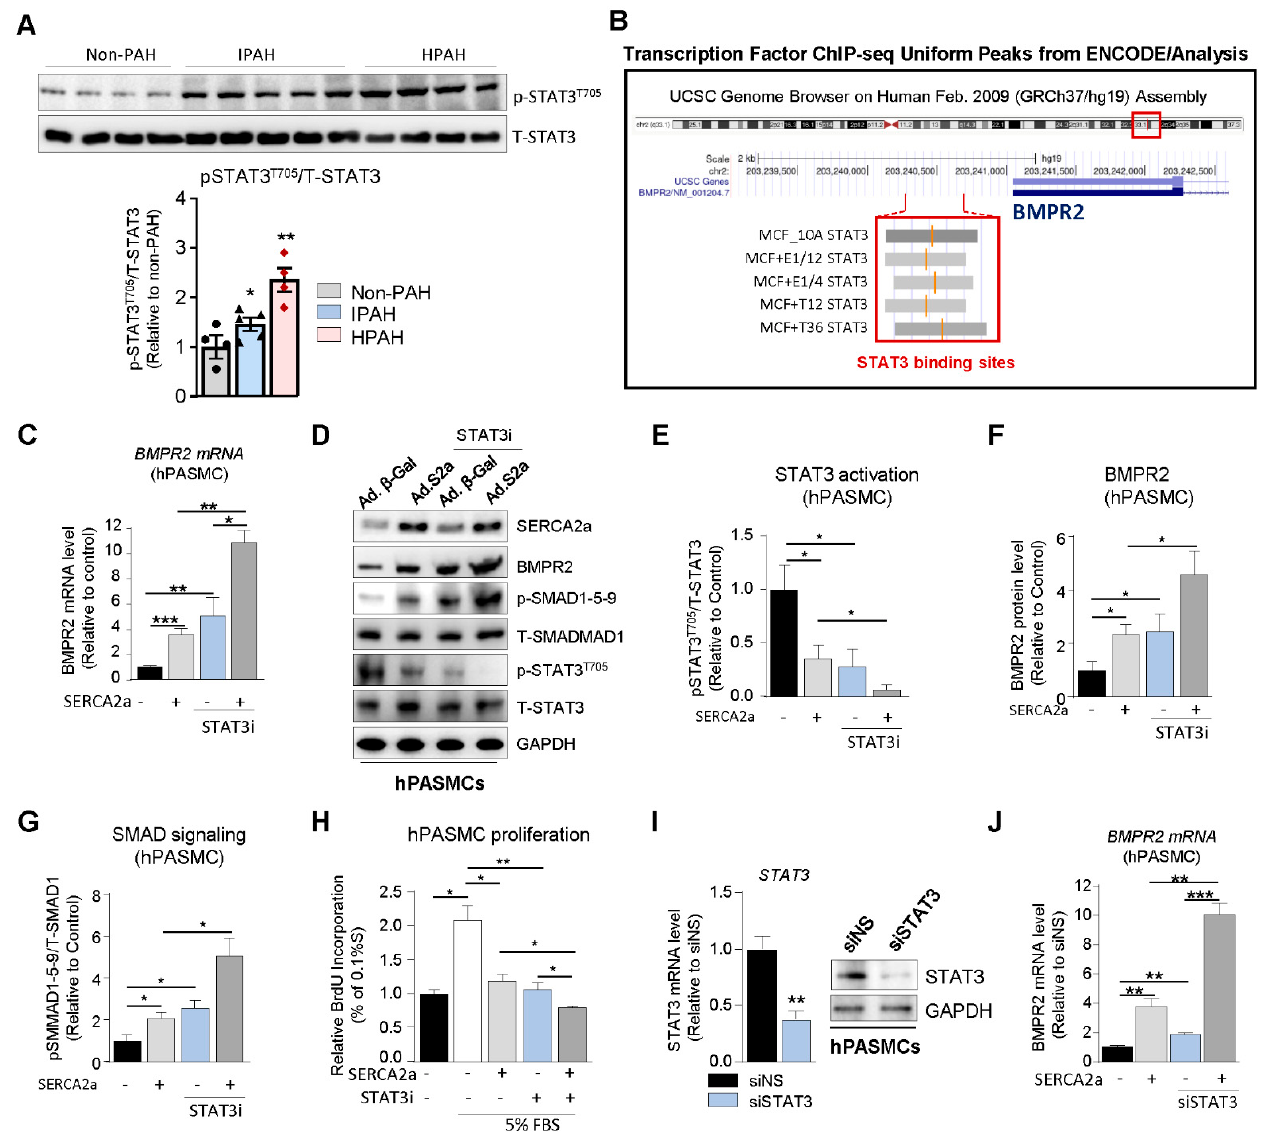
Figure 3. SERCA2a up-regulates BMPR2 expression and downstream SMAD signaling by inhibiting STAT3 activation. ( A ). Upper panel: representative immunoblots of phospho-STAT3 T705 (p-STAT3 T705 ) and Total-STAT3 (T-STAT3) in lung tissue from control non-PAH (n = 4), IPAH (n = 5), and HPAH (n = 4) patients. Total-STAT3 was used as a loading control. Lower panel: the graph represents the quantification of p-STAT3 T705 normalized to T-STAT3. ( B ). BMPR2 promoter region was analyzed for STAT3 binding sites using Transcription Factor ChIP-seq datasets from ENCODE/Analysis (Feb. 2009 data release). ( C ). hPASMCs were transduced with either SERCA2a or a control vector encoding β -Galactosidase (Ad. β Gal) and were treated with potent STAT3 inhibitor HJC0152 (STAT3i) for 48 h (1 μ M). BMPR2 mRNA levels were measured by RT-qPCR in the indicated conditions, n = 3. ( D ). hPASMCs were transduced with a control adenovirus (Ad. β Gal) or SERCA2a (Ad.S2a) and were treated with STAT3i for 48 h (1 μ M). ( E – G ). Bar graph represents the quantification of p-STAT3 T705 ( E ), BMPR2 ( F ), p-SMAD1-5-9 ( G ), and normalized to T-STAT3, GAPDH, and T-SMAD1, respectively, n = 3. ( H ). Proliferation levels were measured through BrdU assay in hPASMCs overexpressing SERCA2a alone for 48 h and/or treated with a potent STAT3 inhibitor (STAT3i, 1 μ M) for 72 h in a media containing 0.1% or 5% FBS, n = 4. ( I ). STAT3 mRNA (left) or protein (right) expression was analyzed by RT-qPCR and Western blot, respectively, in hPASMCs transfected either with a non-silencing siRNA (siNS) or a specific siRNA against STAT3 (siSTAT3) for 72 h, n = 3. ( J ). BMPR2 mRNA levels were measured by RT-qPCR in the indicated conditions after 72 h, n = 3. Data are presented as mean ± SEM; * p < 0.05, ** p < 0.01, *** p < 0.001. SERCA2a overexpression increases BMPR2 expression in hPAECs. Endothelial dys- function and structural remodeling of the pulmonary vessels are early features of PAH [29]. Therefore, we further assessed the role of SERCA2a on BMPR2 expression in hPAECs